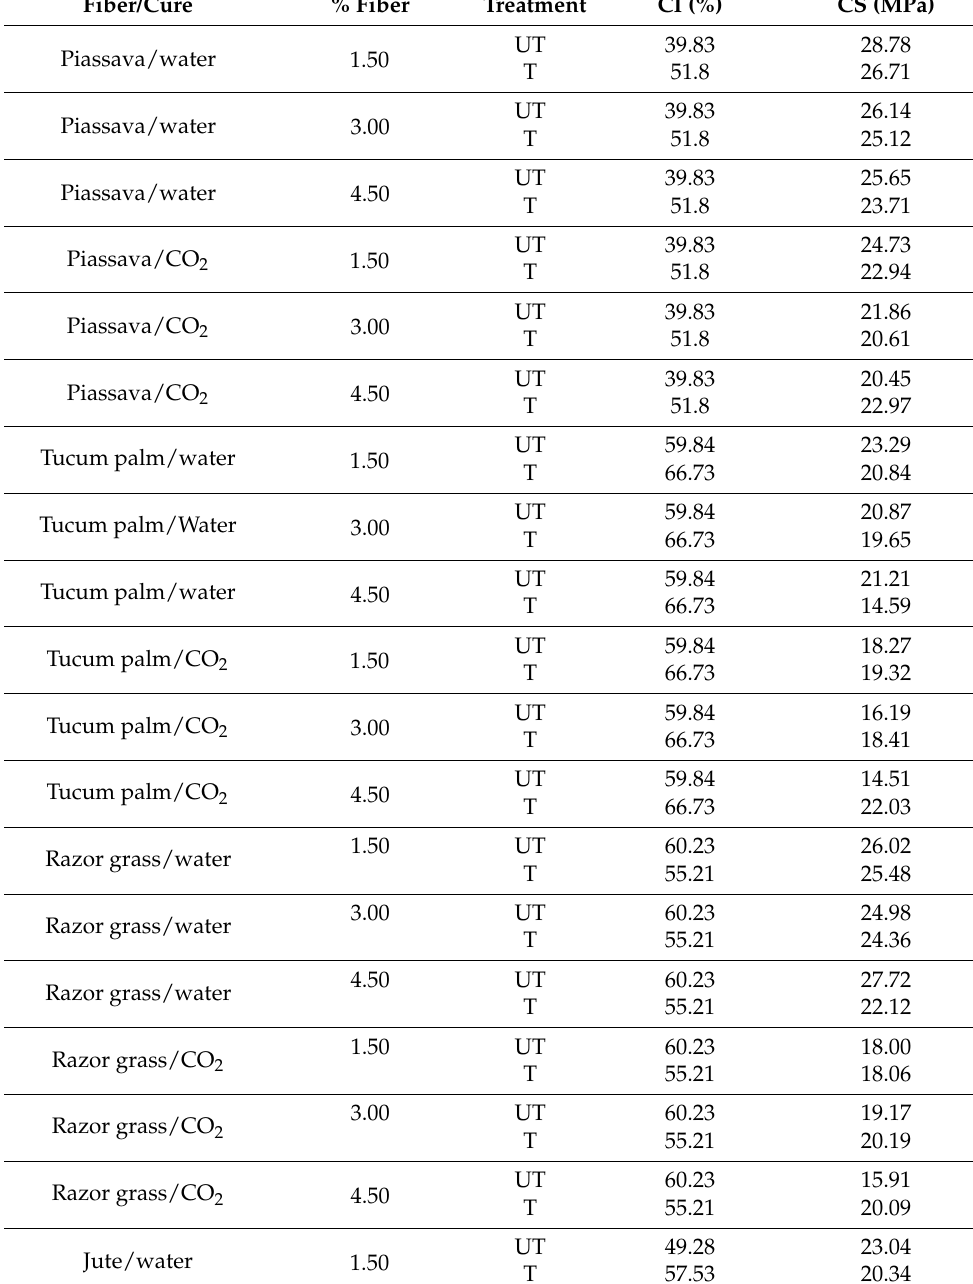
Table 5. Crystallinity index (CI %) and compressive strength (CS) of mortars with untreated and treated